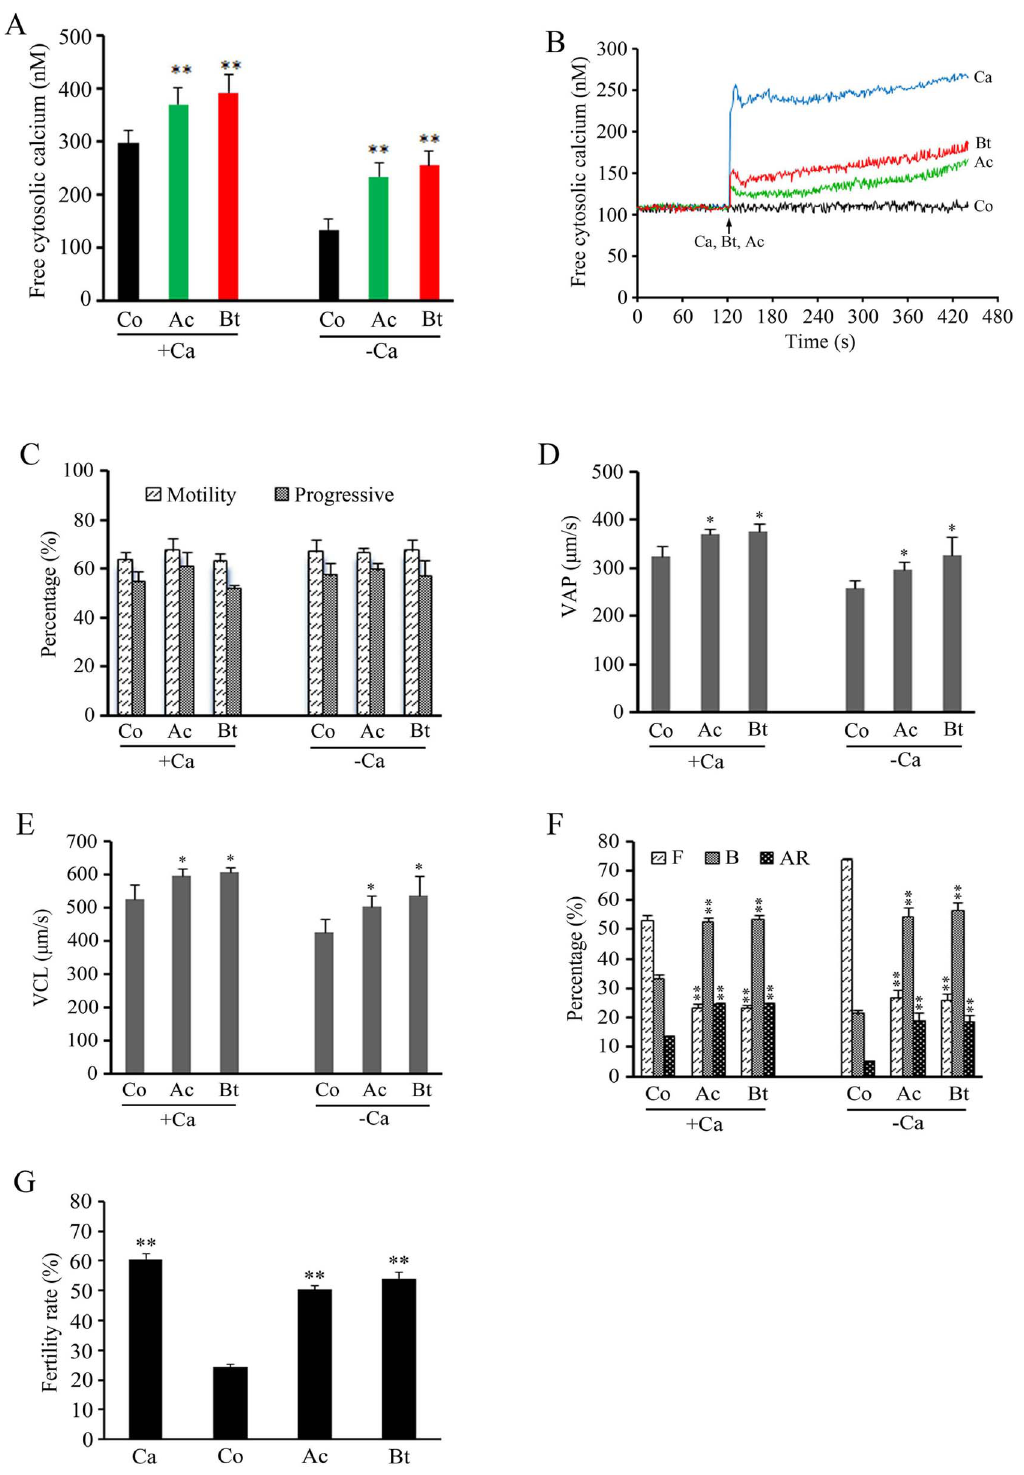
Figure 4. TPPII antagonists regulate sperm function by increasing intracellular calcium. (A) Spermatozoa were treated with AAF-CMK (Ac, 6 m M) and butabindide (Bt, 1000 m M) for 60 min in the absence or presence of 1 mM CaCl 2 and the intracellular Ca 2 + level in the sperm was examined. Results are expressed as the mean 6 SEM (n=7). **P , 0.001, as compared with the corresponding controls (Co) (unpaired t test). (B) Effect of AAF-CMK (Ac, 6 m M) and butabindide (Bt, 1000 m M) on the release of sperm intracellular Ca 2 + . The arrow indicates the time points at which the calcium iron or antagonists were added. A representative of four experiments is presented. Control (Co) is the basal level. The final concentration of calcium (Ca) is 1 mM, obtained by the addition of 100 mM CaCl 2 solution. (C–E) Spermatozoa were treated with AAF-CMK (Ac, 6 m M) and butabindide (Bt, 1000 m M) for 60 min in the absence or presence of 1 mM CaCl 2 . The percentage (C), VAP (D), and VCL (E) of sperm motility were examined using CASA. Results are expressed as the mean 6 SEM (n=4). *P , 0.05 as compared with the corresponding control (Co) (unpaired t test). (F) Spermatozoa